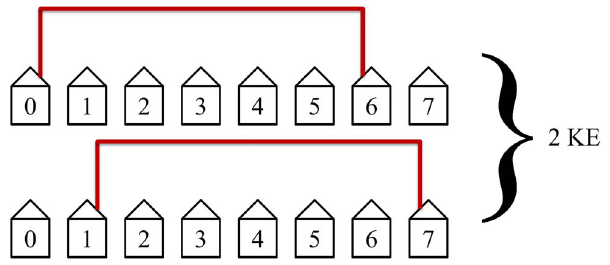
Figure 14. The first step in the protocol connects the nearest neighbors. This step is the quickest and most efficient. It has the most non-overlapping simultaneous loops and requires only 1 KE to